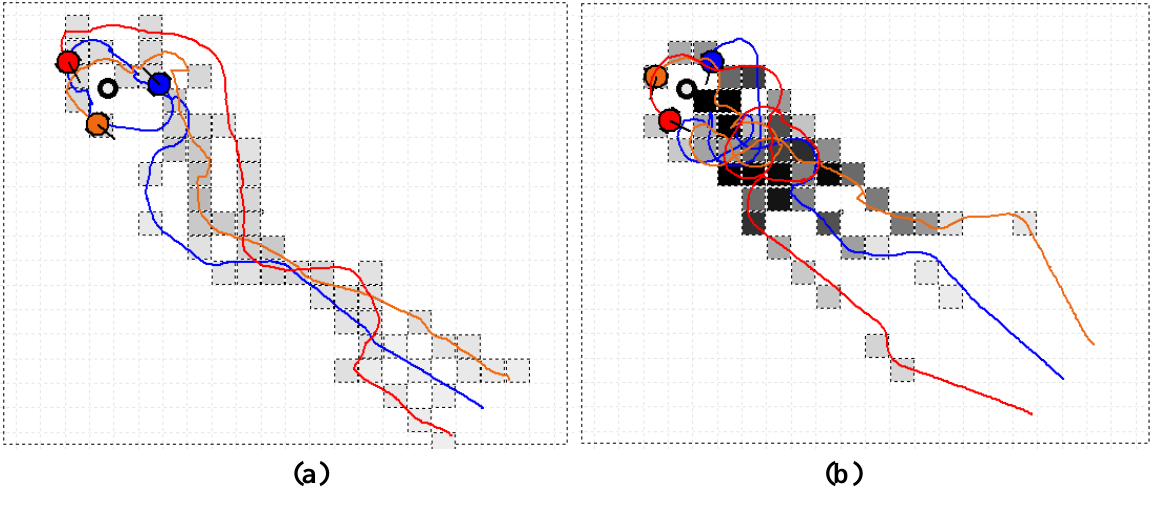
Figure 14. Two of recorded collective OSL and search processes, the robots started from the lower right corner. (a) Artificial wind (the total search time was 413 s); (b) Natural wind (the total search time was 862